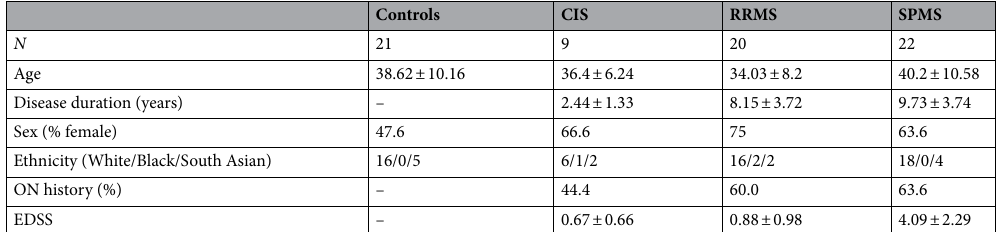
Table 1. Demographic and clinical characteristics of the study cohort. Data are expressed as mean ± standard deviation or as %. CIS clinically Isolated syndrome, EDSS expanded disability status scale, ON optic